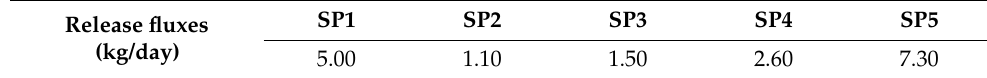
Table 4. The true release fluxes of the contaminant source.